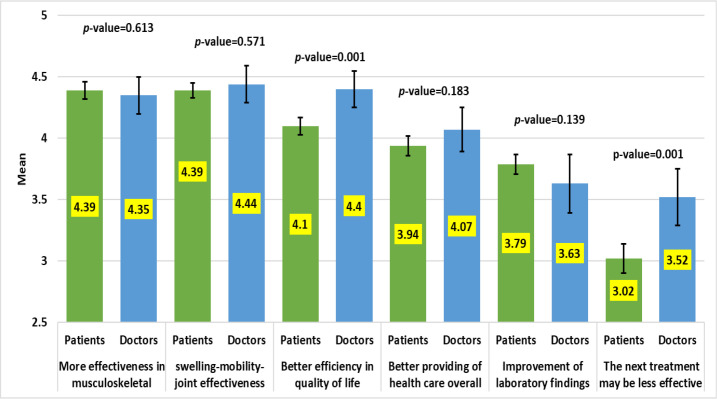
Importance of factors in switching treatment.
Note: p-values from t-tests of the mean difference between doctors and patients’ responses for each dimension.